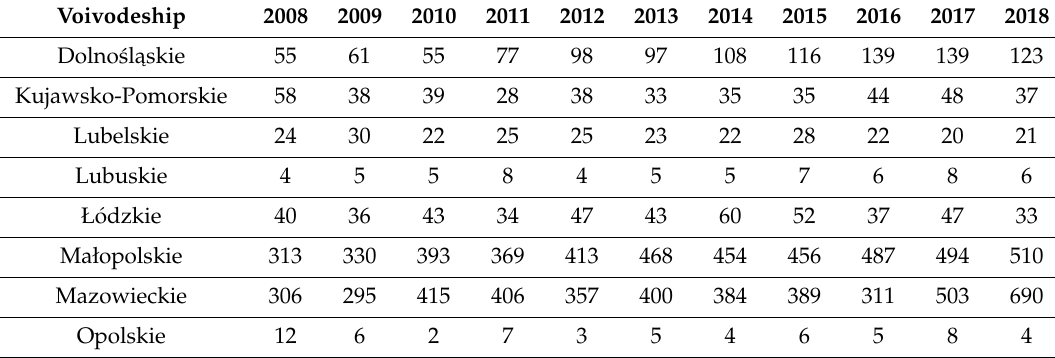
Figure 5. Percentage of patients diagnosed with E84 who benefitted from various services in 2018. Table 3. Number of E84 patients using hospital services financed by the National Health Fund during the 2008–2018